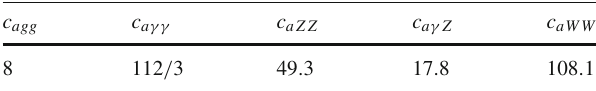
Table2 Thecoefficientsoftheaxioncouplingstothegaugebosonfield strengths in the physical basis are reported, where the normalisation is defined in Eq.